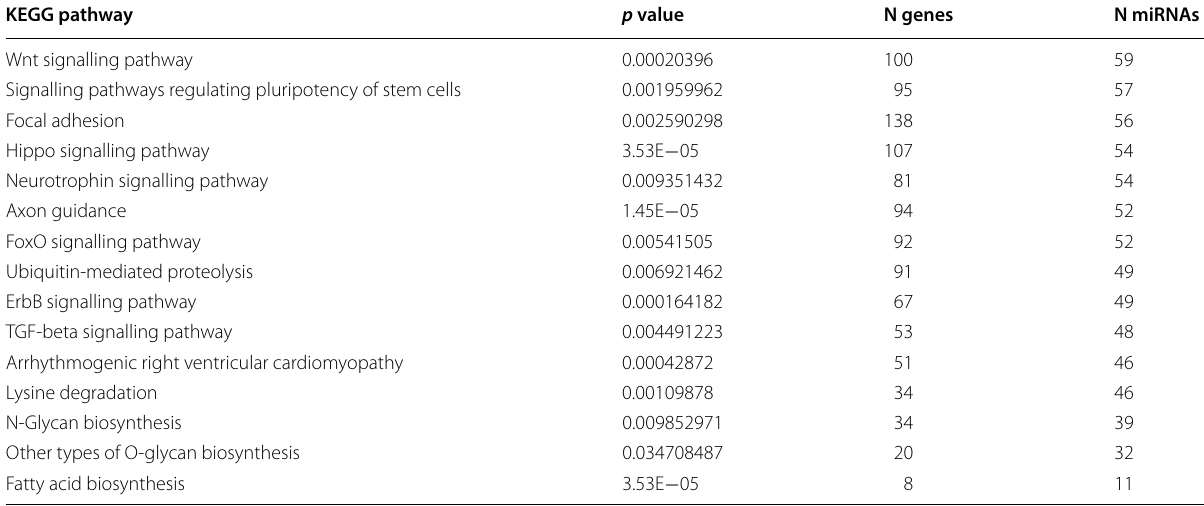
These pathways were identified from the intersection of the DIANA-mirPath results of three databases (TargetScan, Tarbase7.0, and microT-CDS v5.0) with exclusion of tumour, hepatitis B, leukaemia, and thyroid hormone-related pathways